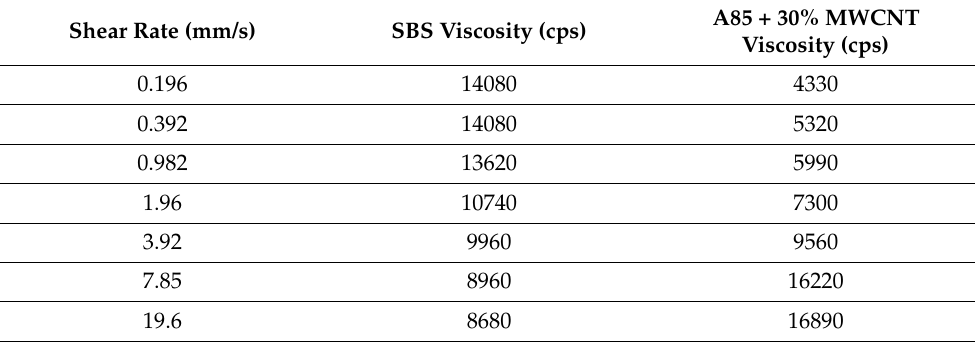
Table 1. Viscosity measurements for unfilled SBS solution and filled multiwalled carbon nanotubes (MWCNT) loaded A85 solution, showing shear-thinning behavior for unfilled and shear-thickening behavior for filled solutions.